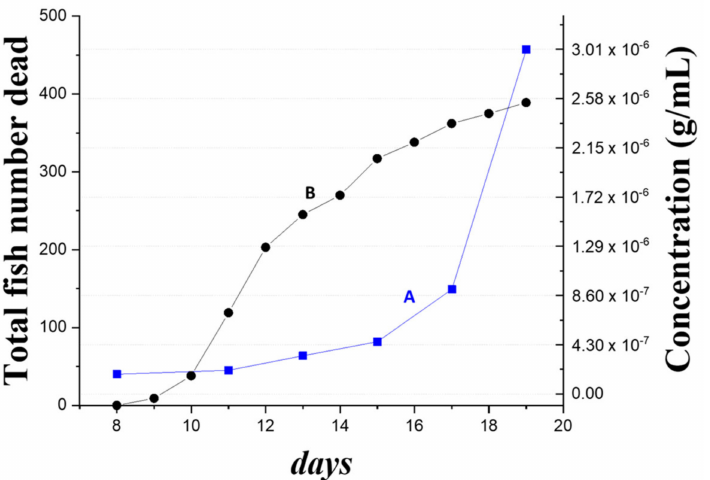
Figure 6. The detected concentration of NNV coat proteins in an infected pond using FOPPR biosensor (curve A) from the eighth day to the nineteenth day during a larvae cultivation process; the death toll of grouper larvae (curve B) in the same time